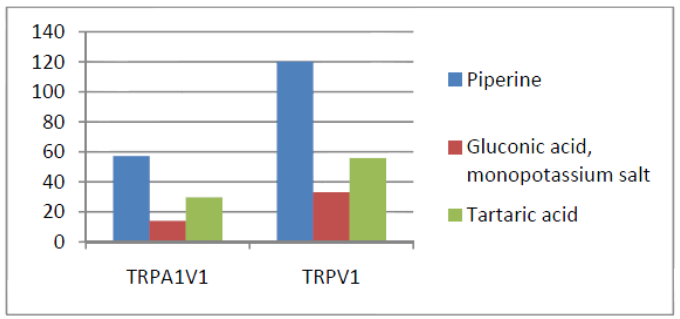
Figure 8. Examples of compounds that activate TRPV1 > TRPA1V1, but not TRPA1.